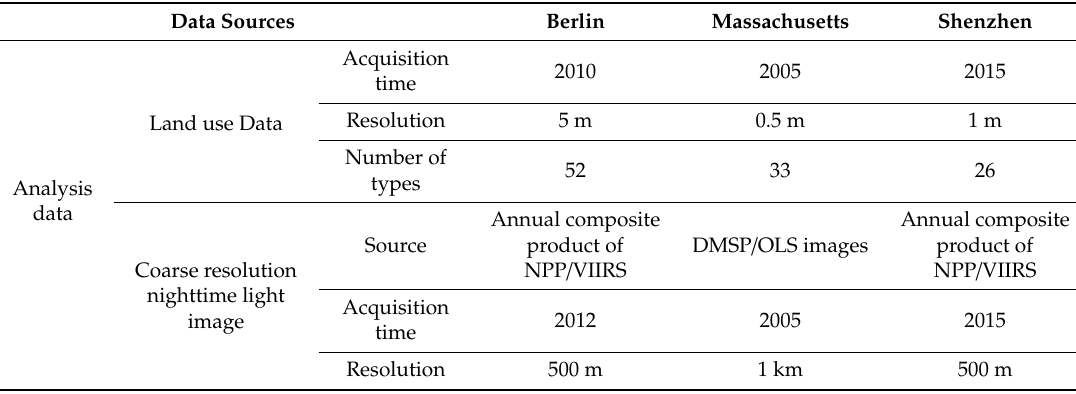
Table 1. Experimental data of the three research areas.